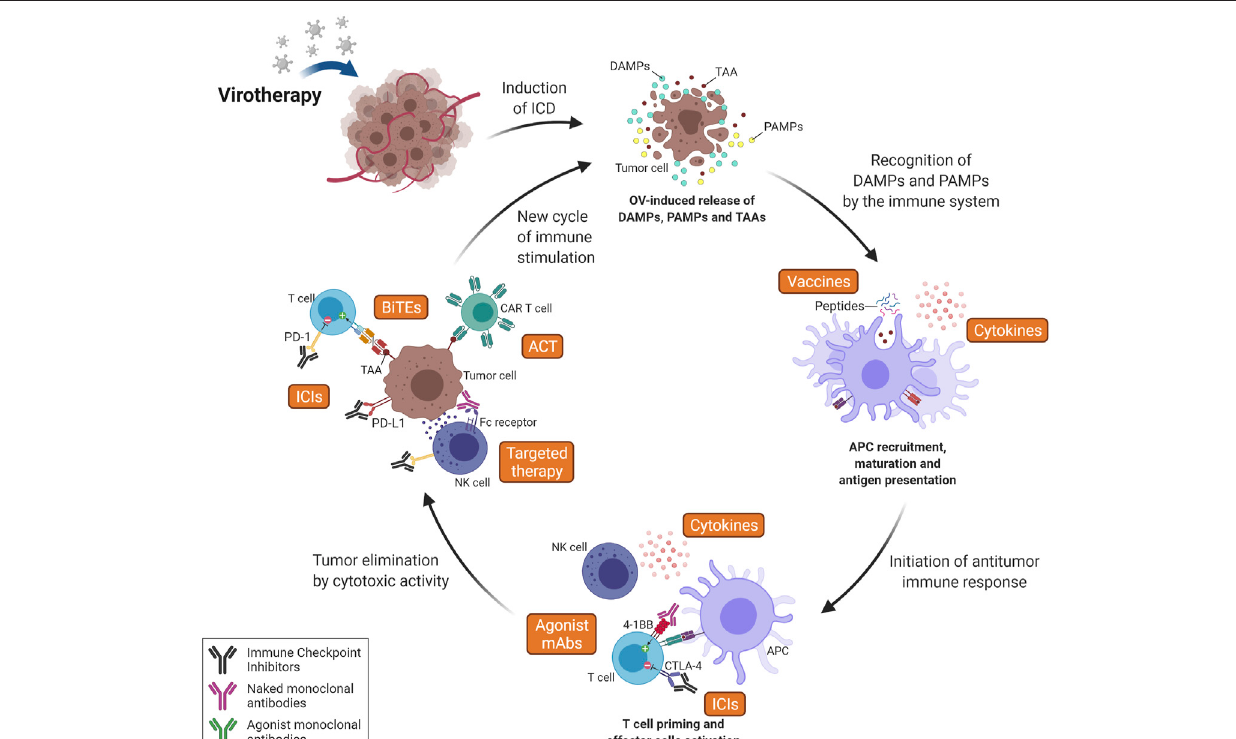
FIGURE 4 | Combining Oncolytic Virus (OV) therapy with other immunotherapy strategies. Since OV acts at the fi rst step of the cancer-immunity cycle, releasing DAMPs, PAMPs and TAAs, its association with additional interventions aiming to establish an antitumor response is favored. The induction of ICD leads to recruitment and activation of antigen-presenting cells (APCs), which can increase the ef fi ciency of vaccine-based approaches (especially peptide vaccines) and generate a stronger T cell response. Immune Checkpoint Inhibitors (ICIs) can increase activation of T cells during priming (here represented by anti-CTLA-4 mAb) and also increase T-cell effector activity in the tumor (i.e., anti-PD-(L)1 mAbs) following OV-induced immune cell in fi ltration. Agonist monoclonal antibodies (mAbs) are also an interesting intervention to increase T cell activation against TAAs (released after oncolytic therapy) by recognizing and activating costimulatory T cell receptors (i.e., 4-1 BB). Targeted therapy can also potentiate the immune responses to target tumor cells by increasing the effector activity of the innate immune system, including NK cell- mediated ADCC, macrophage-mediated ADCP and complement-mediated CDC. It is important to note that the cytotoxic activity of innate immune cells increases antigen release and, consequently, T cell recruitment. Virotherapy can also increase ef fi ciency of Adoptive Cell Therapy (ACT), here represented by CAR T cells, by promoting a pro-in fl ammatory microenvironment, enabling T cells enhanced functions and leading to a higher recognition and elimination of tumor cells even in solid tumors. Therapy using bi-speci fi c antibodies, such as BiTEs, can also be enhanced by oncolytic therapy as OVs precondition tumors in terms of T cell recruitment and activation. Finally, cytokines can act at many key steps of the process, such as antigen presentation and T cell priming, activation and recruitment. Furthermore, these factors have an important role at maintaining a favorable microenvironment for the survival of activated immune cells and the sustainment of the immune response. ICD, Immunogenic Cell Death; TAA, Tumor-Associated Antigen; DAMPs, Damage-Associated Molecular Pattern; PAMPs, Pathogen-Associated Molecular Pattern; NK, Naturalkiller;CTLA-4,CytotoxicT-Lymphocyte-Associatedprotein4;PD-1,ProgrammedcellDeathprotein1;PD-L1,ProgrammedcellDeathLigand1;CAR,Chimeric Antigen Receptor; BiTEs, Bi-speci fi c T-cell Engagers; ADCC, Antibody-Dependent Cell-mediated Cytotoxicity; ADCP, Antibody-Dependent Cellular Phagocytosis; CDC, Complement-Dependent Cytotoxicity. Created with